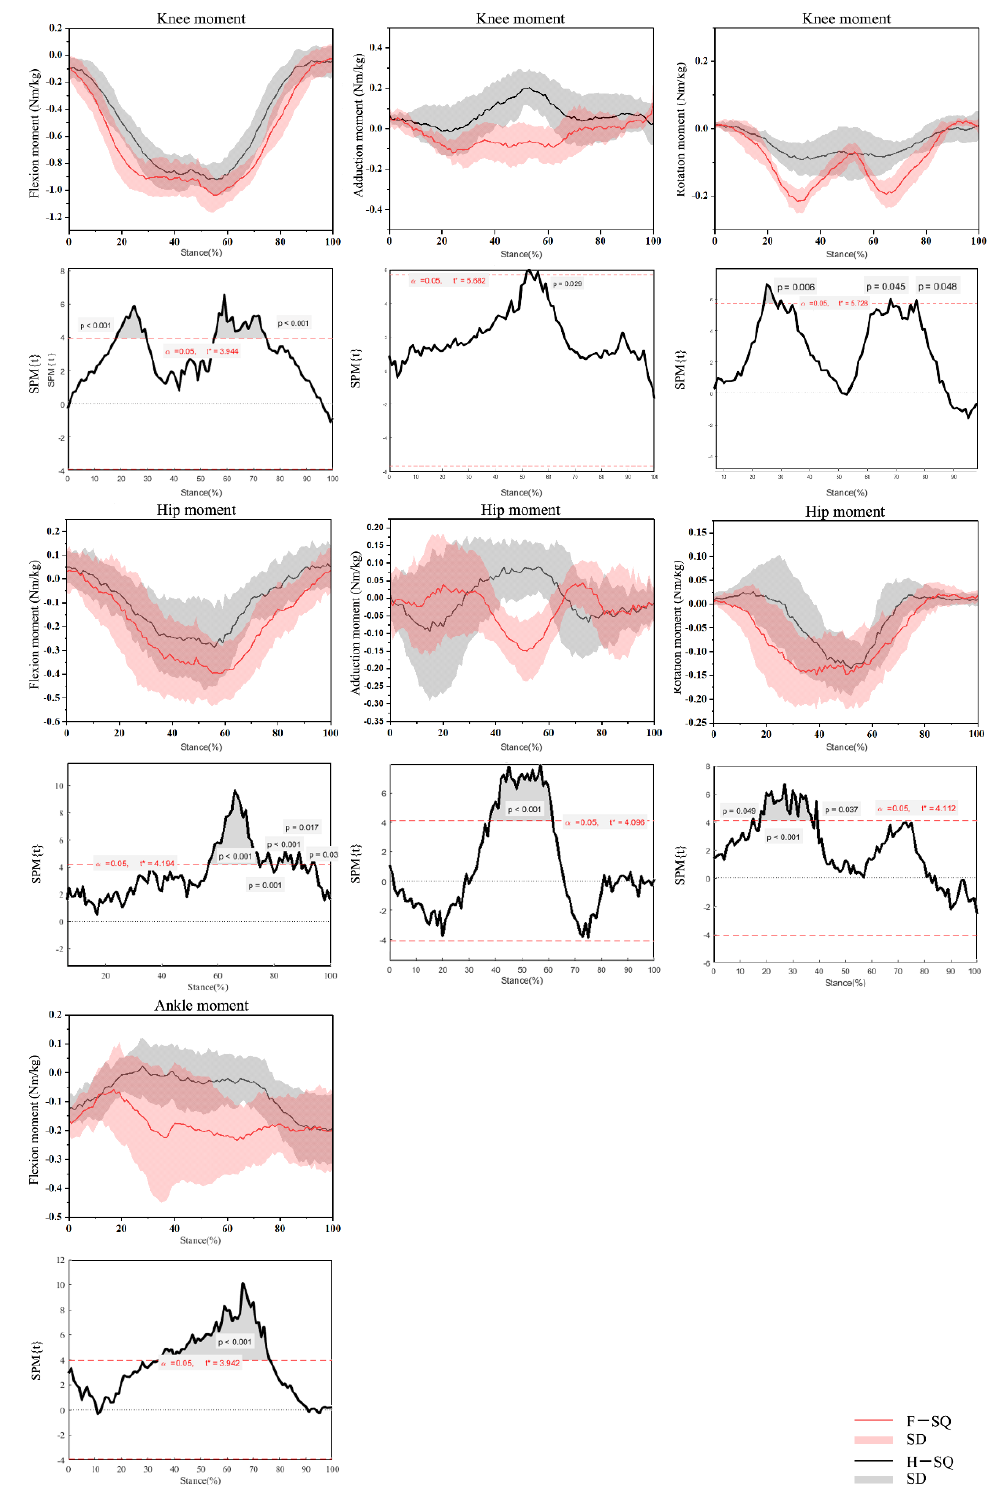
Figure 3. Waveform of moments in the hip, knee and ankle joints during F-SQ and H-SQ with highlighted statistics using